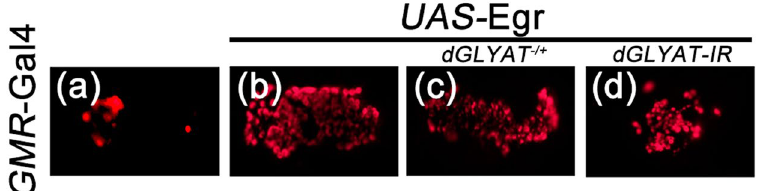
Figure 9. Loss of dGLYAT suppresses ectopic Egr-induced ROS activation in eye discs. Light micrographs of Drosophila eye discs are shown. Compared with the GMR -Gal4 control ( a ), GMR > Egr-induced ROS positive staining ( b ) is suppressed by mutation ( c ) or RNAi-mediated depletion ( d ) of dGLYAT (a, n = 8; b, n = 6; c, n = 5; d, n =